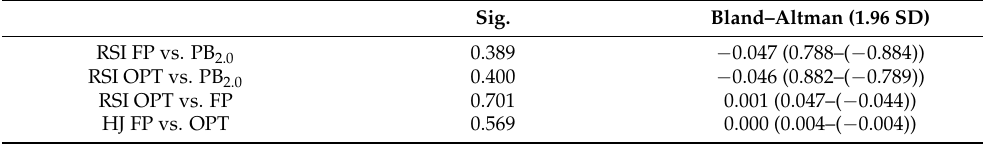
Table 2. Concurrent validation t-test significance and Bland–Altman between measuring devices during DJ30.